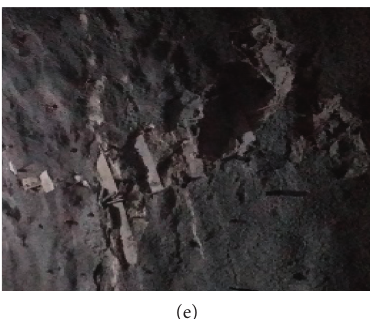
Figure 9: Second excavation stage (E3 and E4) and deformations of surrounding rocks.